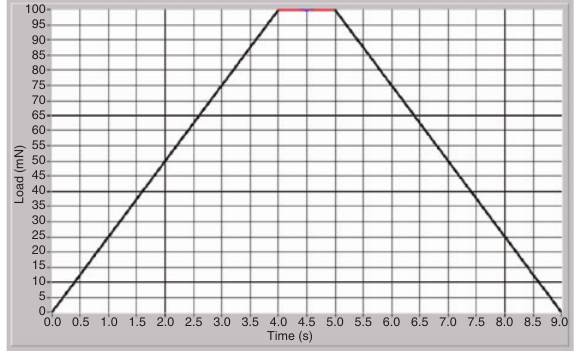
Figure 1: Load versus time curve, illustration of trapezoidal sequence.